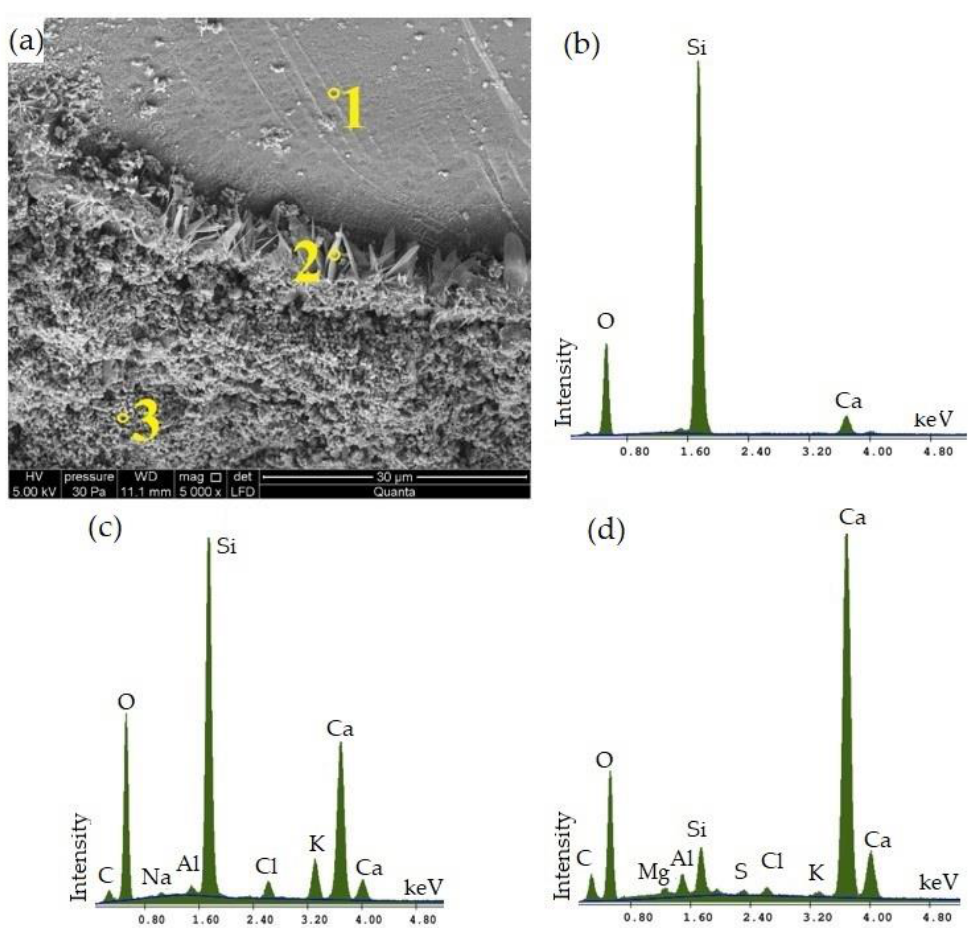
Figure 8. Microscopic SEM image of calcium – silica samples with 33% CBPD at ( a ) 5000× magnifica- tion and X-ray microanalysis of its elemental composition at ( b ) 1, ( c ) 2 and ( d ) 3.